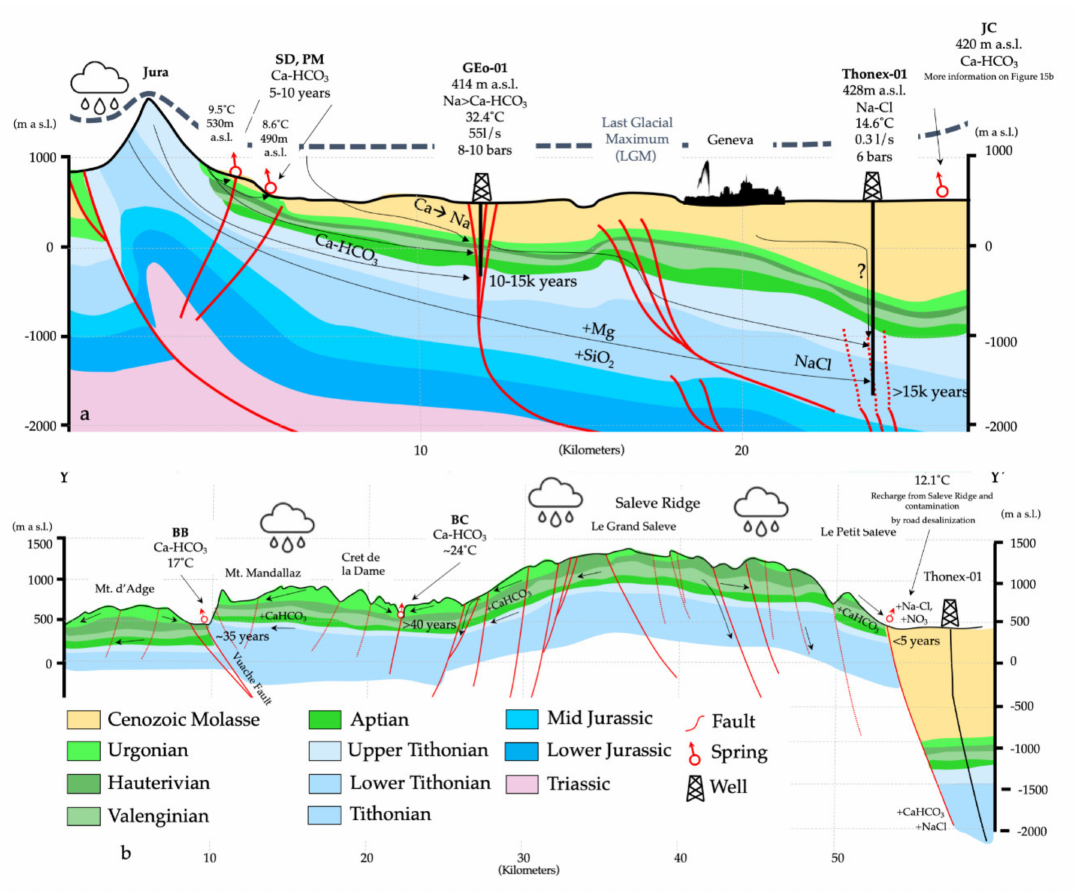
Figure 17. Geothermal fluid flow conceptual models along two cross-sections in the NW-SE ( a ) and SW-NE ( b ) directions (for accurate position of the profiles refer to Figure